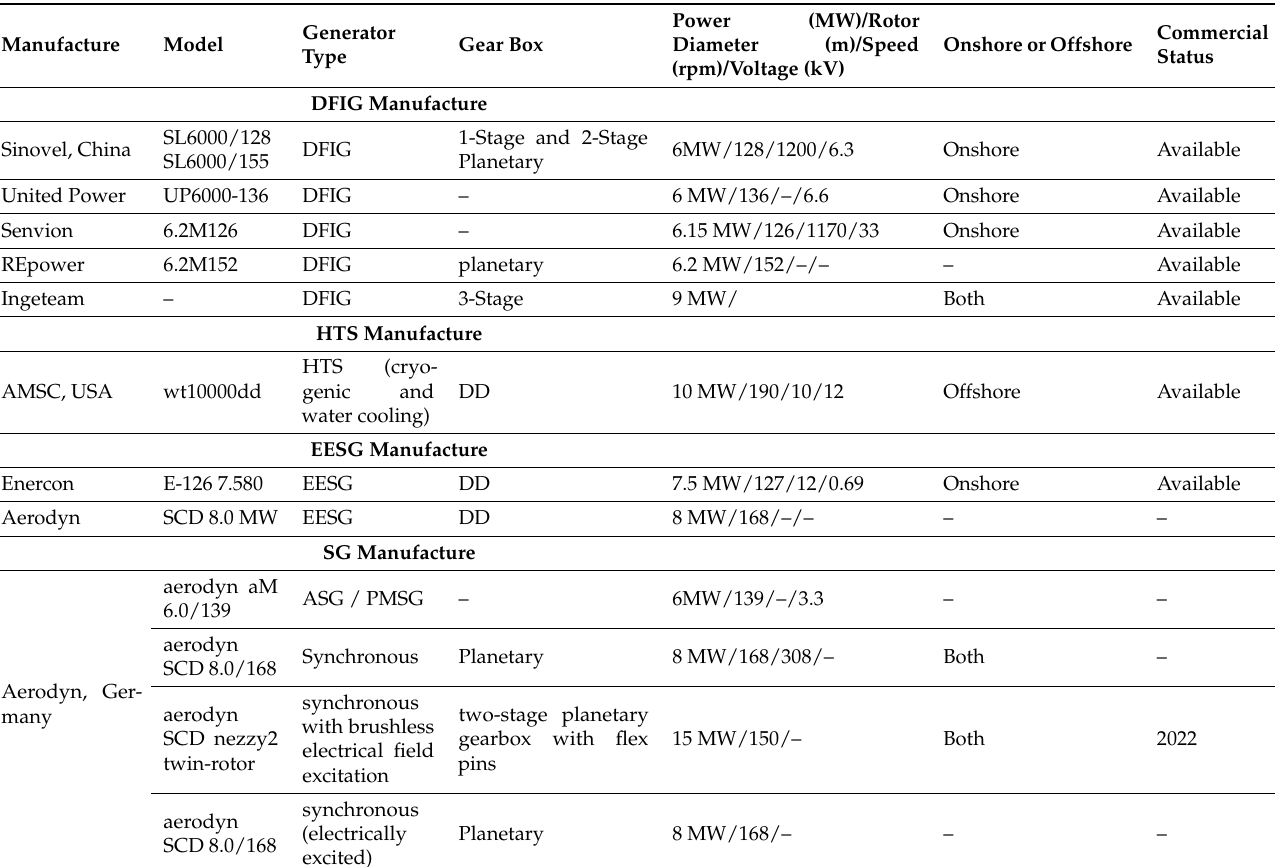
Table 2. Different topologies of High power WT